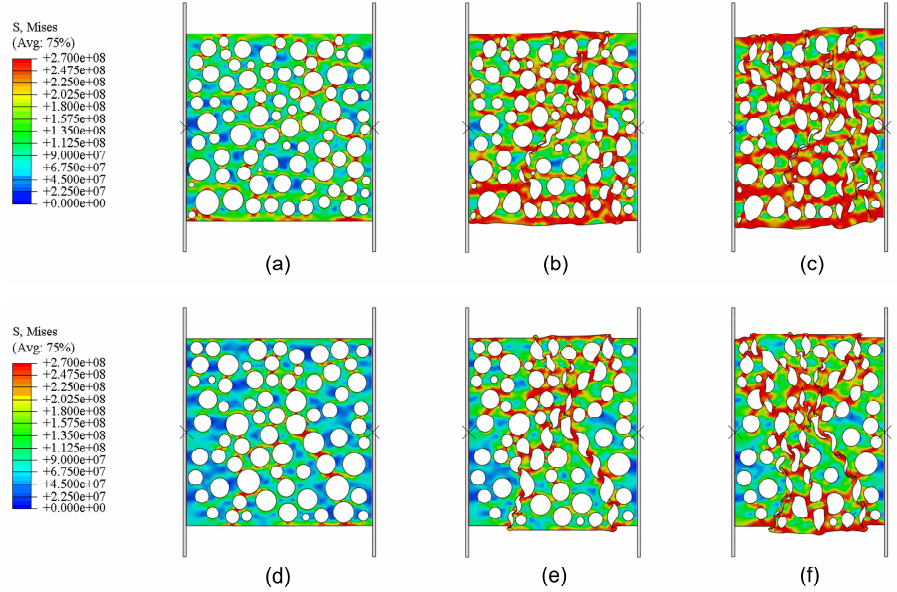
Figure 15. Deformation diagram of the structure with the highest plateau stress ( a–c ) and the lowest plateau stress ( d – f ) for compressive strain values of 0.03 ( a , d ), 0.1 ( b , e ), and 0.2 ( c , f ).